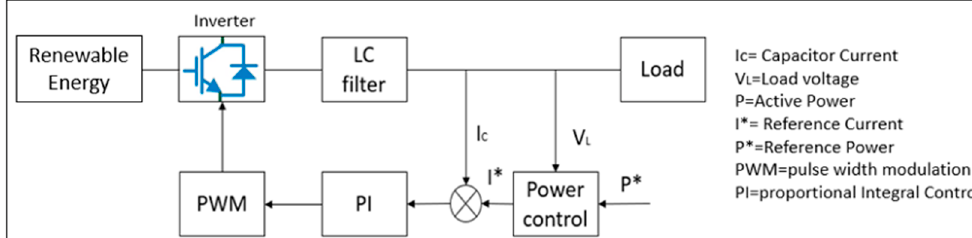
Figure 7. Example of constant current control with power control.